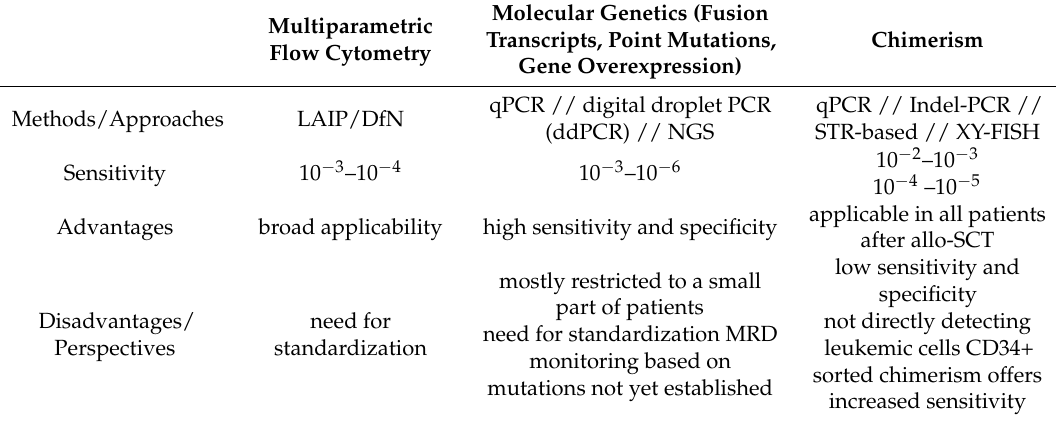
Table 1. Methods to detect Minimal Residual Disease (MRD) in Patients with AML after